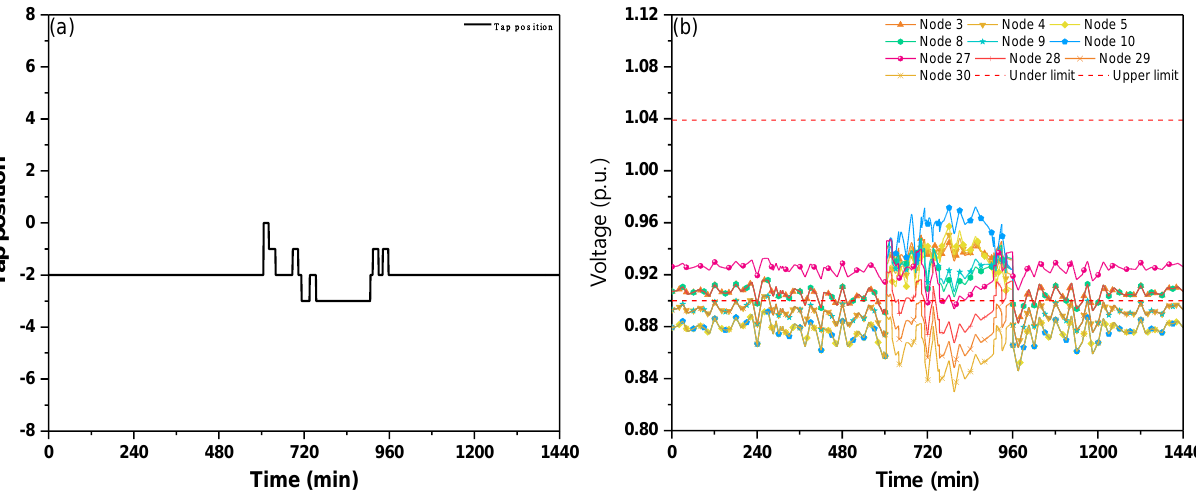
Figure 10 shows the simulation results of Case 3. Because Case 3 only operates with the load line (Feeder 6), only the voltage of the Feeder 6 is compensated even if a reverse power flow occurs. Therefore, the positive tap position is maintained even in the reverse power flow situation. This can solve the low-voltage problem of all lines in the forward power flow; however, over-voltage occurs in the PV-connected line in the reverse power flow situation.